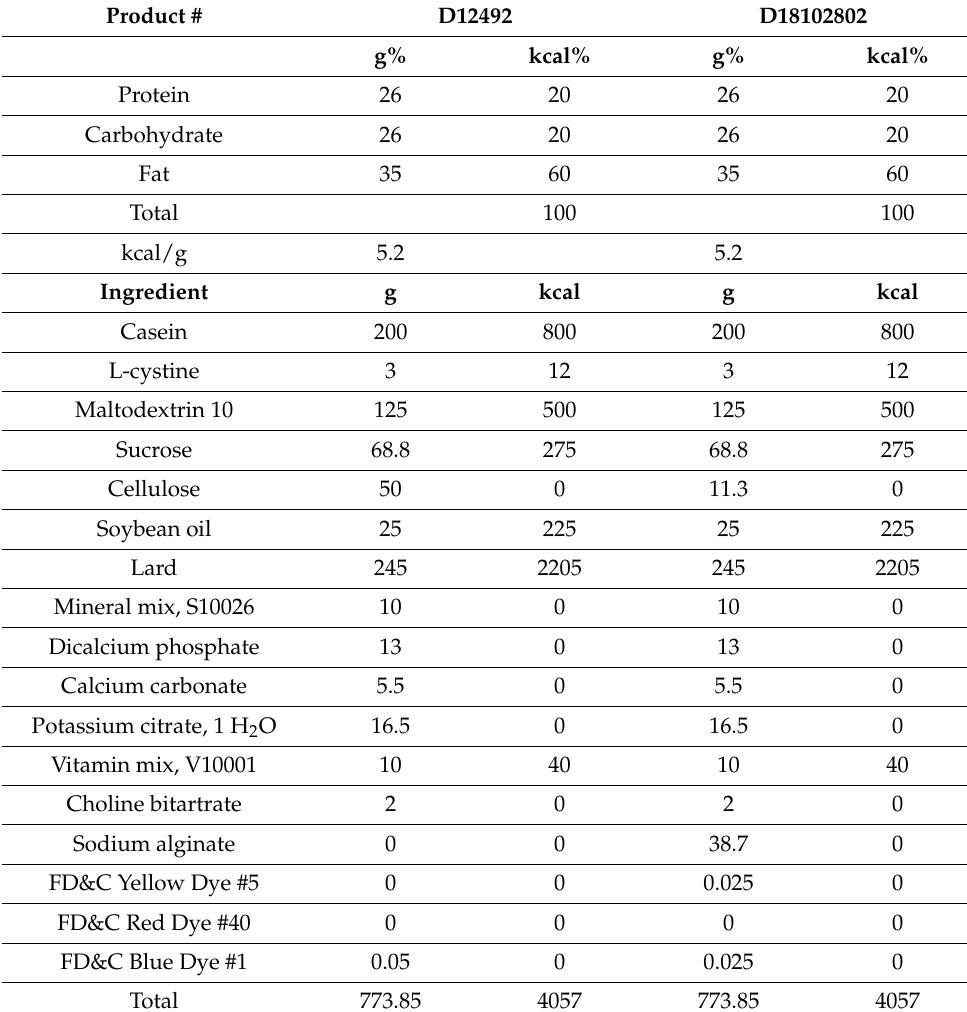
Table 1. Composition of the diet used for the